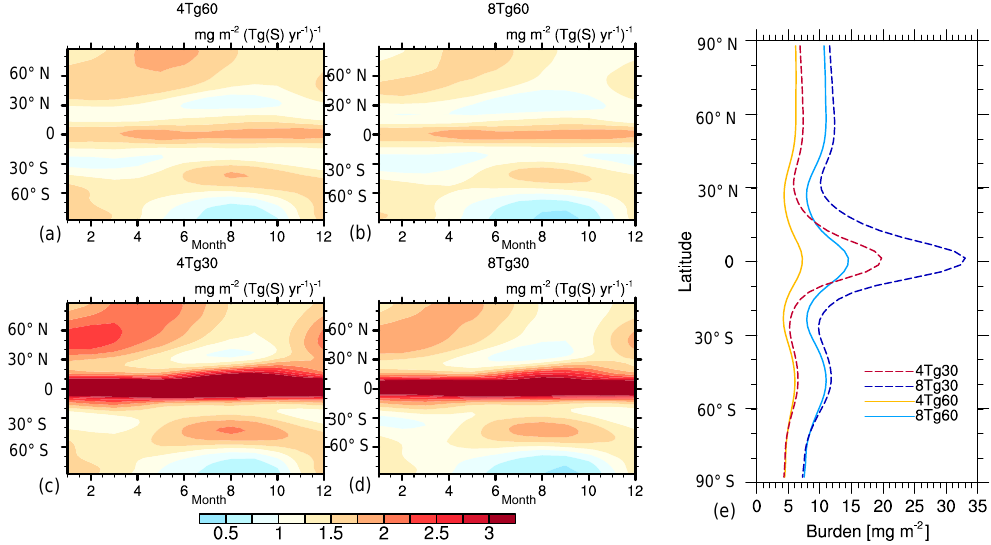
Figure 7. (a–d) : Zonal and multi-year monthly means of normalized sulfate burden [mgm − 2 ( Tg ( S ) yr − 1 ) − 1 ], plotted as Hovmøller diagram, for injection rates of 4Tg ( S ) yr − 1 (a, c) and 8Tg ( S ) yr − 1 (b, d) and injection heights of 60hPa (a, b) and 30hPa (c, d) . To normalize the data each field is divided by the injection rate. (e) : Zonally averaged non-normalized sulfate